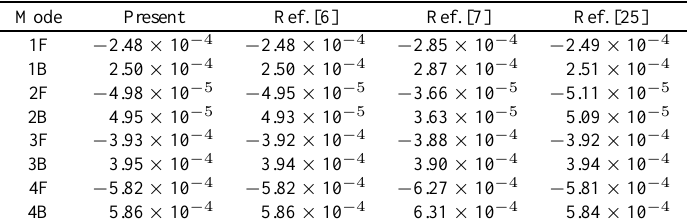
Table 2 Logarithmic decrement δ of a uniform shaft with isotropic undamped bearings